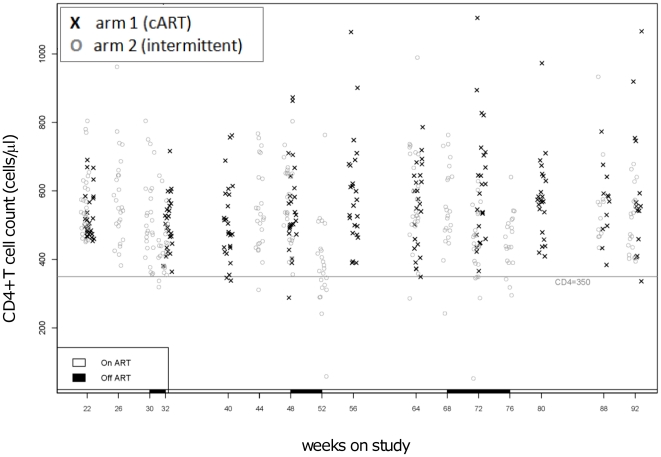
CD4 counts over the study period.The graphic represents individual CD4+ T cell counts at each study visit. Crosses = cART; circles = intermittent ART; the continuous line represent the CD4+ T cell count cutoff for failure (350 cells/µl).